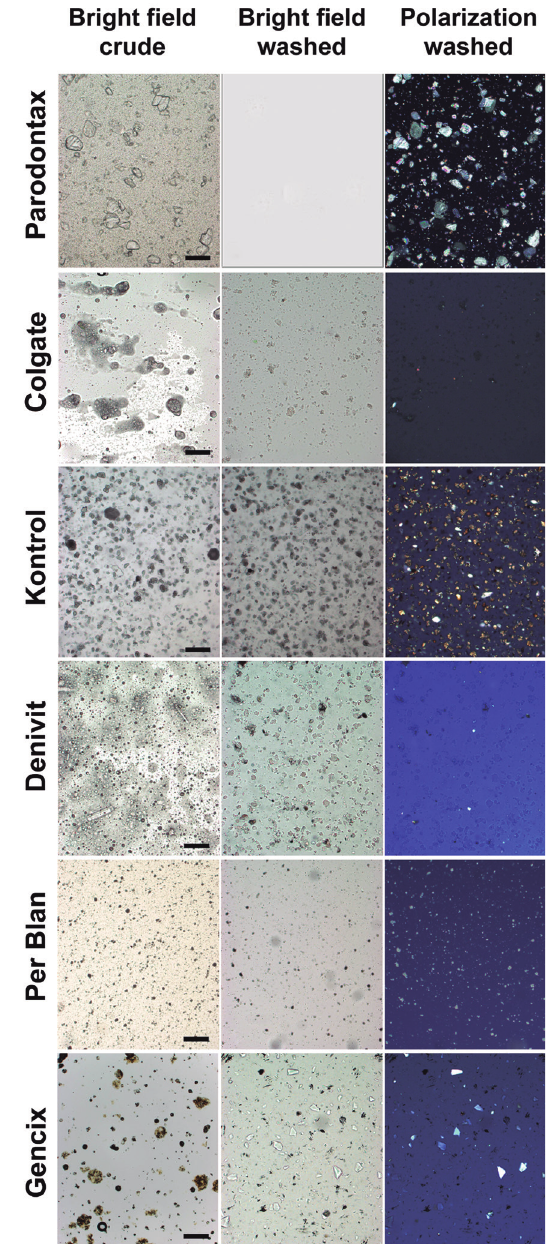
Figure 2- Light microscopic aspect of the six dentifrices studied at the same magnification (100x; the bar stands for 200 µm). For each of them, the image of the 1st column corresponds to the appearance of the crude dentifrice under glass slide and coverslip in bright field microscopy. The 2 nd column corresponds to the abrasive powder obtained after extensive washes and examined under glass slide and coverslip in bright field